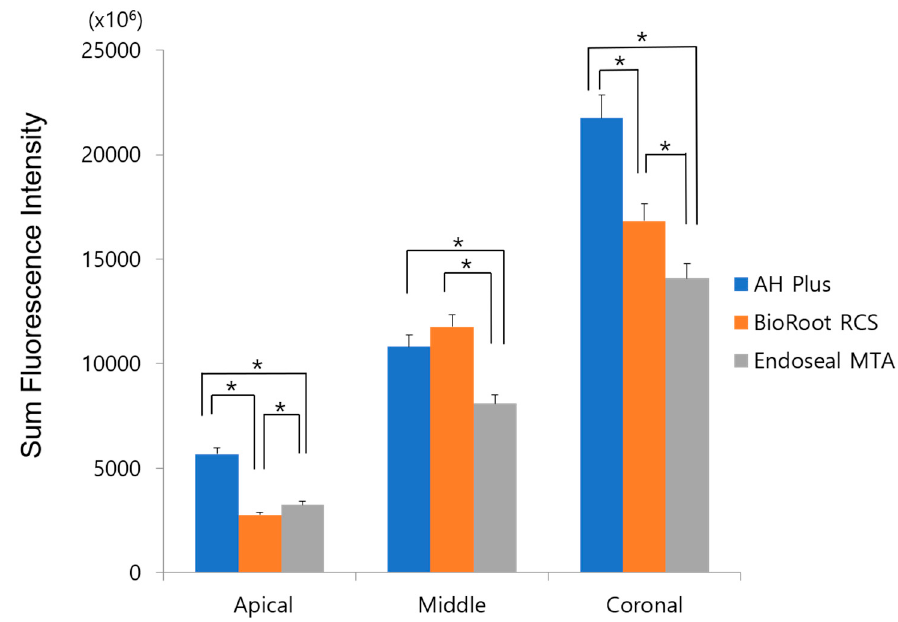
Figure 1. Sum fluorescence intensity of rhodamine B dye in the apical, middle, and coronal thirds of all experimental sealers. Stars indicate a statistically significant difference.